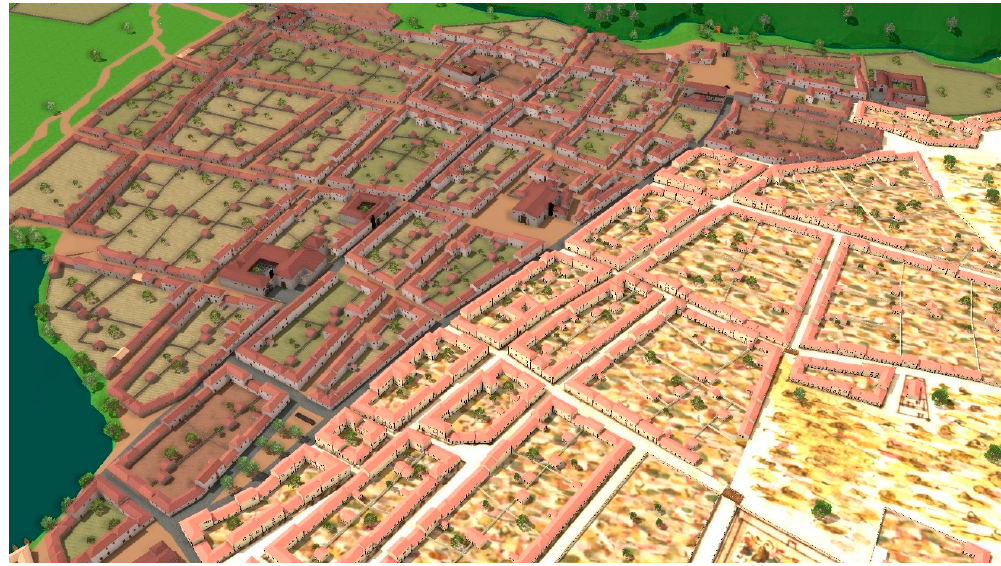
Figure 28. An image from the 3D Web viewer.